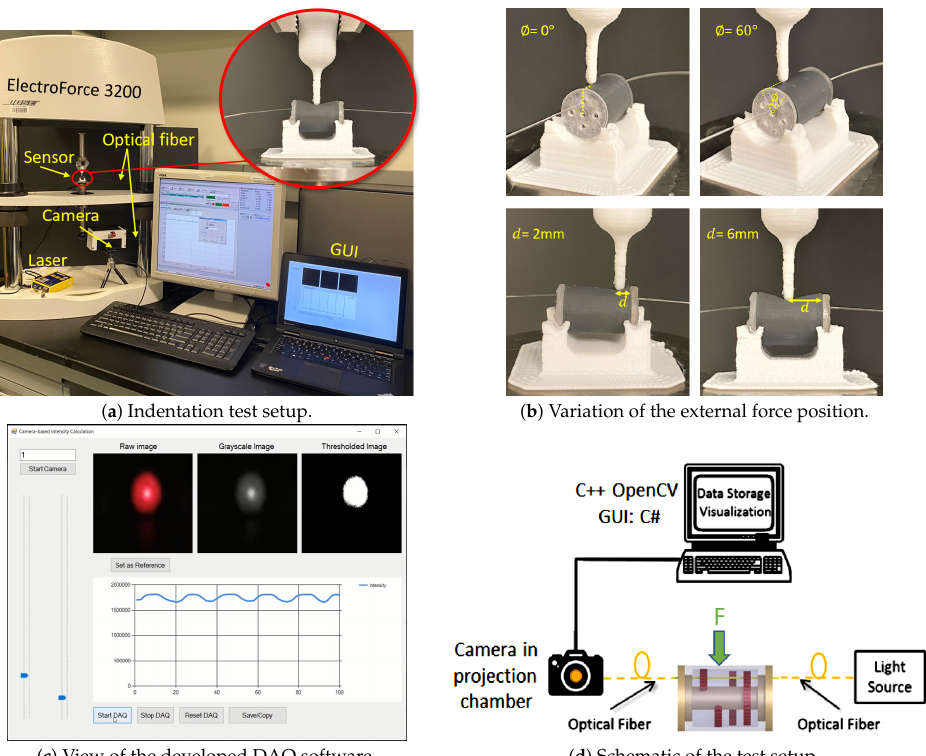
Figure 9. ( a ) Experimental setup, image-based DAQ and fabricated sensor under the test, ( b ) the prototype sensor under various load cases in the experimental study, ( c ) a representative view of the developed GUI software to record the intensity change in real time, ( d ) schematic system